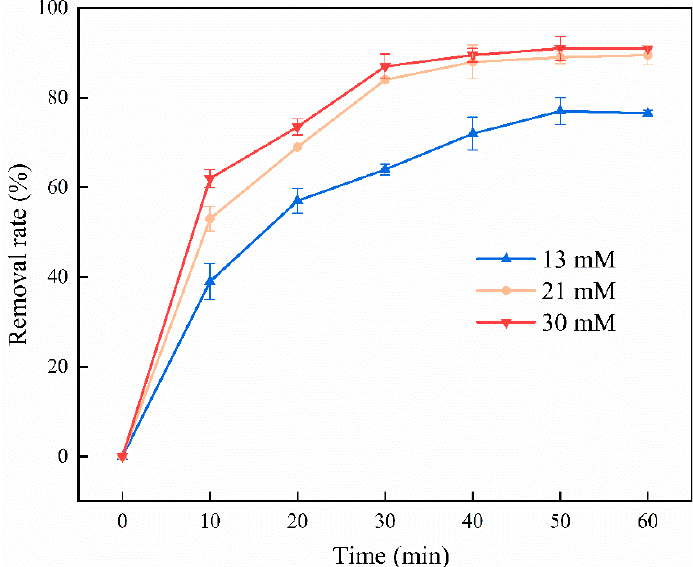
Figure 5. Effect of persulfate concentration on the degradation of pyrene. Experimental conditions: [ZVI] = 3 g/L; 25 °C; 160 rpm; no pH adjustment.